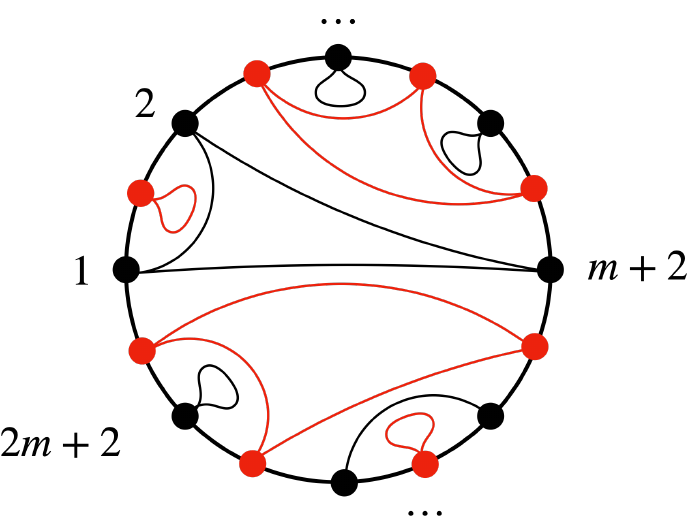
Figure 16 . A circular lattice of 2 m +2 elements is shown as black dots. The dual lattice is the red dots. We show an example of a non-crossing permutation on the red lattice that factorizes across the first and m + 2 nd elements of the original lattice. Clearly, the Kreweras complement (shown in black lines) connects the first and m + 2 nd elements such that ζ ( τ ) = 1